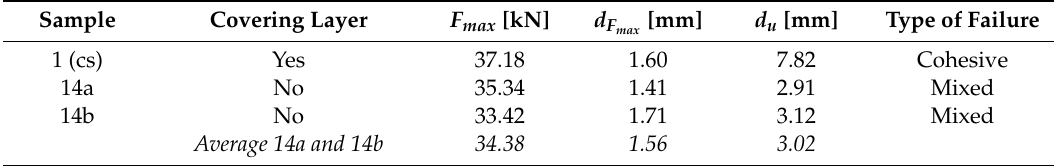
Table 4. Experimental results for samples 1, 14a and 14b.